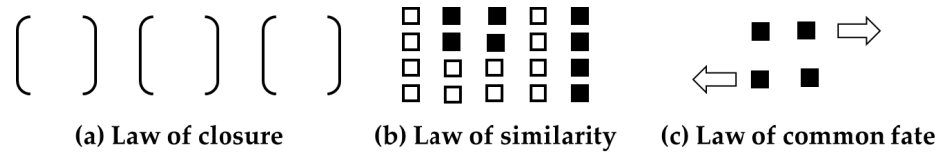
Figure 1. Principle of Prägnanz in Gestalt theory. ( a ) Law of closure, ( b ) Law of similarity, and ( c ) Law of common fate are factors of principle of Prägnanz.